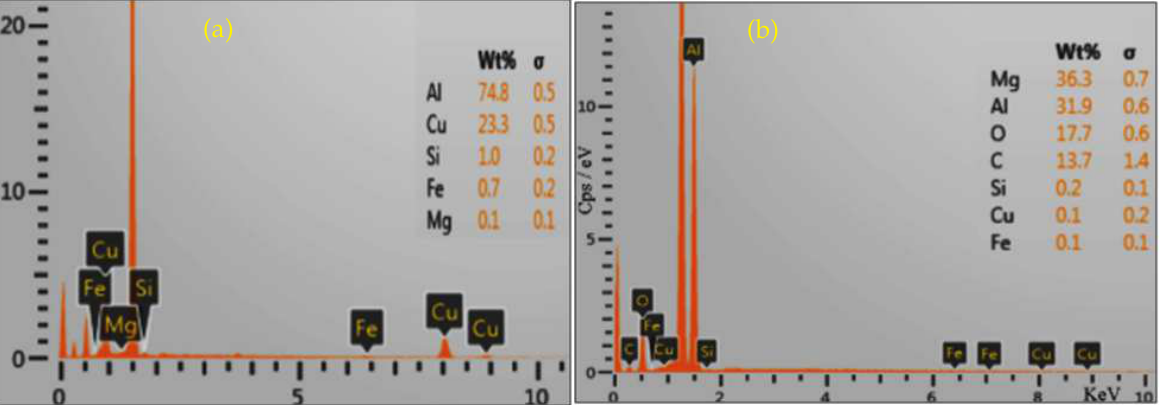
Figure 6. Typical EDS spectrums of Al-CuMgMn sample. ( a ) Composition of spectrum 14 (alloy region); and ( b ) Composition of spectrum 18(substrate region).